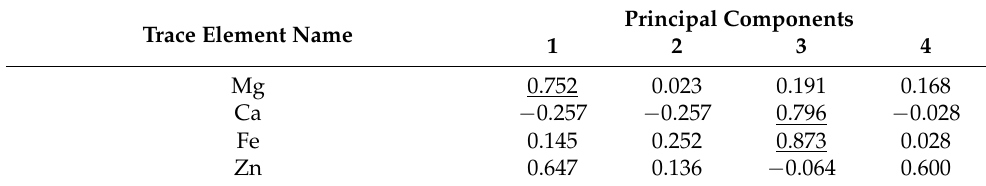
Figure 1. Principal component analysis of trace elements in buckwheat flour. Table 2. Total variance description through principal component analysis and varimax orthogonal rotated factor loading matrix.